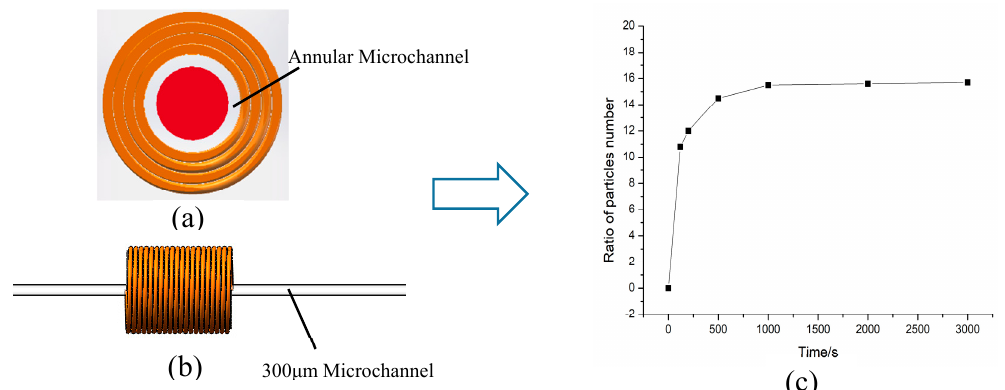
Figure 12. High-throughput comparison of microchannels. ( a ) The 300 µ m annular microchannel designed in this paper; ( b ) 300 µ m microchannel designed in the early stage; ( c ) Experimental results of high-throughput.